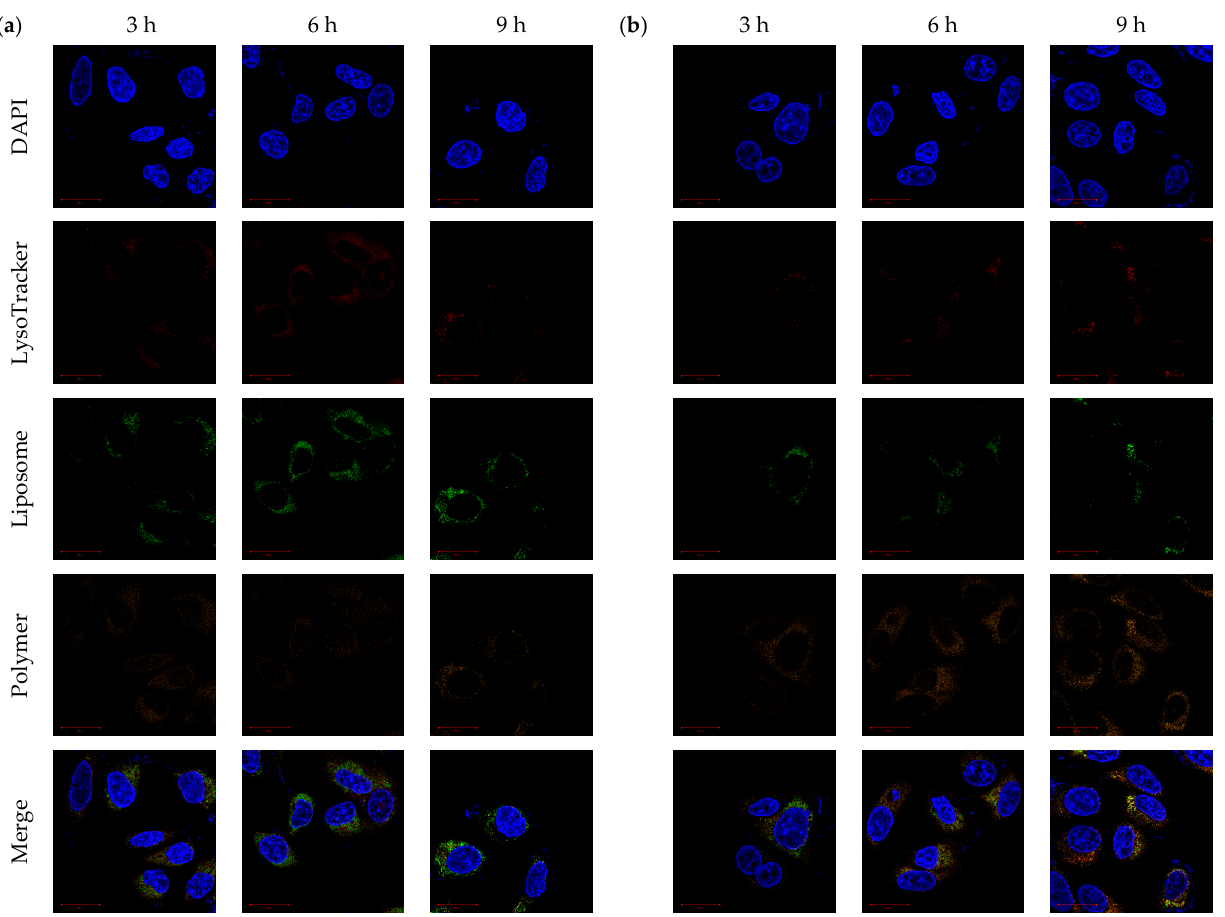
Figure 7. Endosomal escape of polymer–liposome complexes. Confocal images of ( a ) PCLH and ( b ) PCLM after co-incubation with MCF-7 cells for 3, 6, and 9 h. Scale bar: 20 μ m ( n = 3, showing one of the measurements from the data).